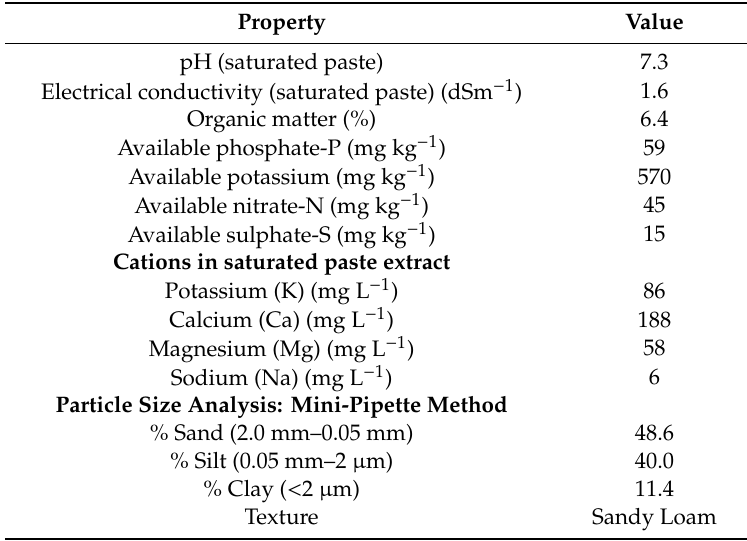
Table 1. Physicochemical properties of the Black Chernozem (Typic Haplocryoll) soil used for the biological N 2 fixation